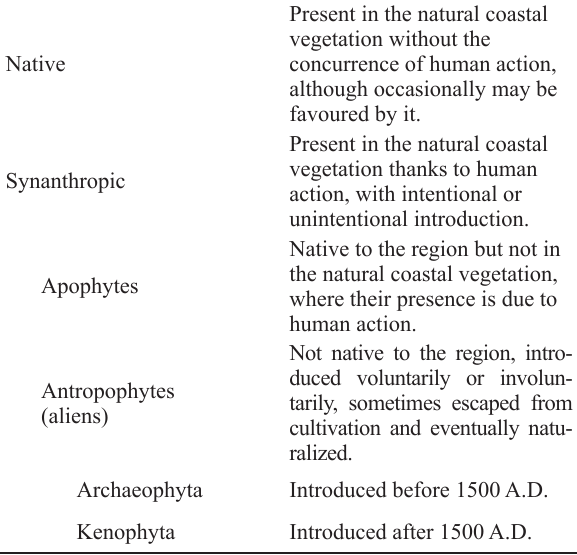
Table 1. Plant classification according to the origin and human action. Source: Kornaś (1990) .